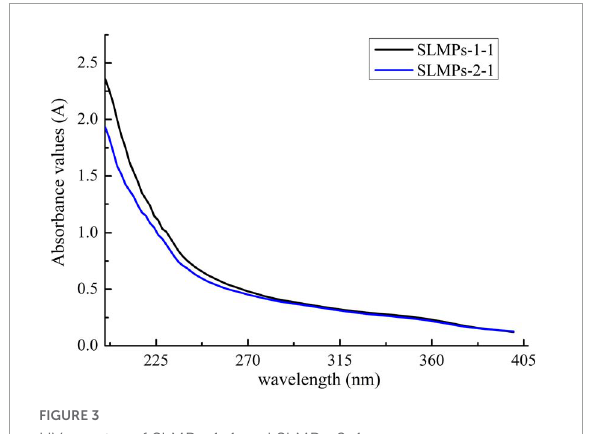
FIGURE3 UV spectra of SLMPs-1-1 and SLMPs-2-1.